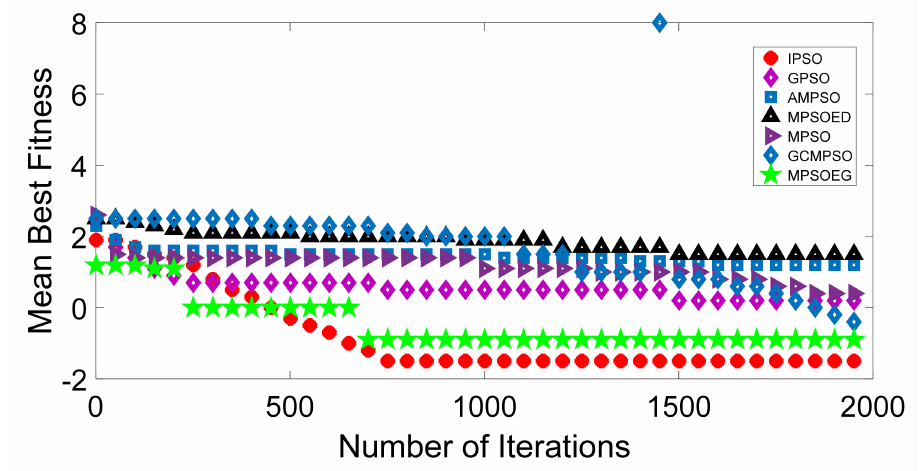
Figure A5. Algorithms’ convergence plots on f 8 .